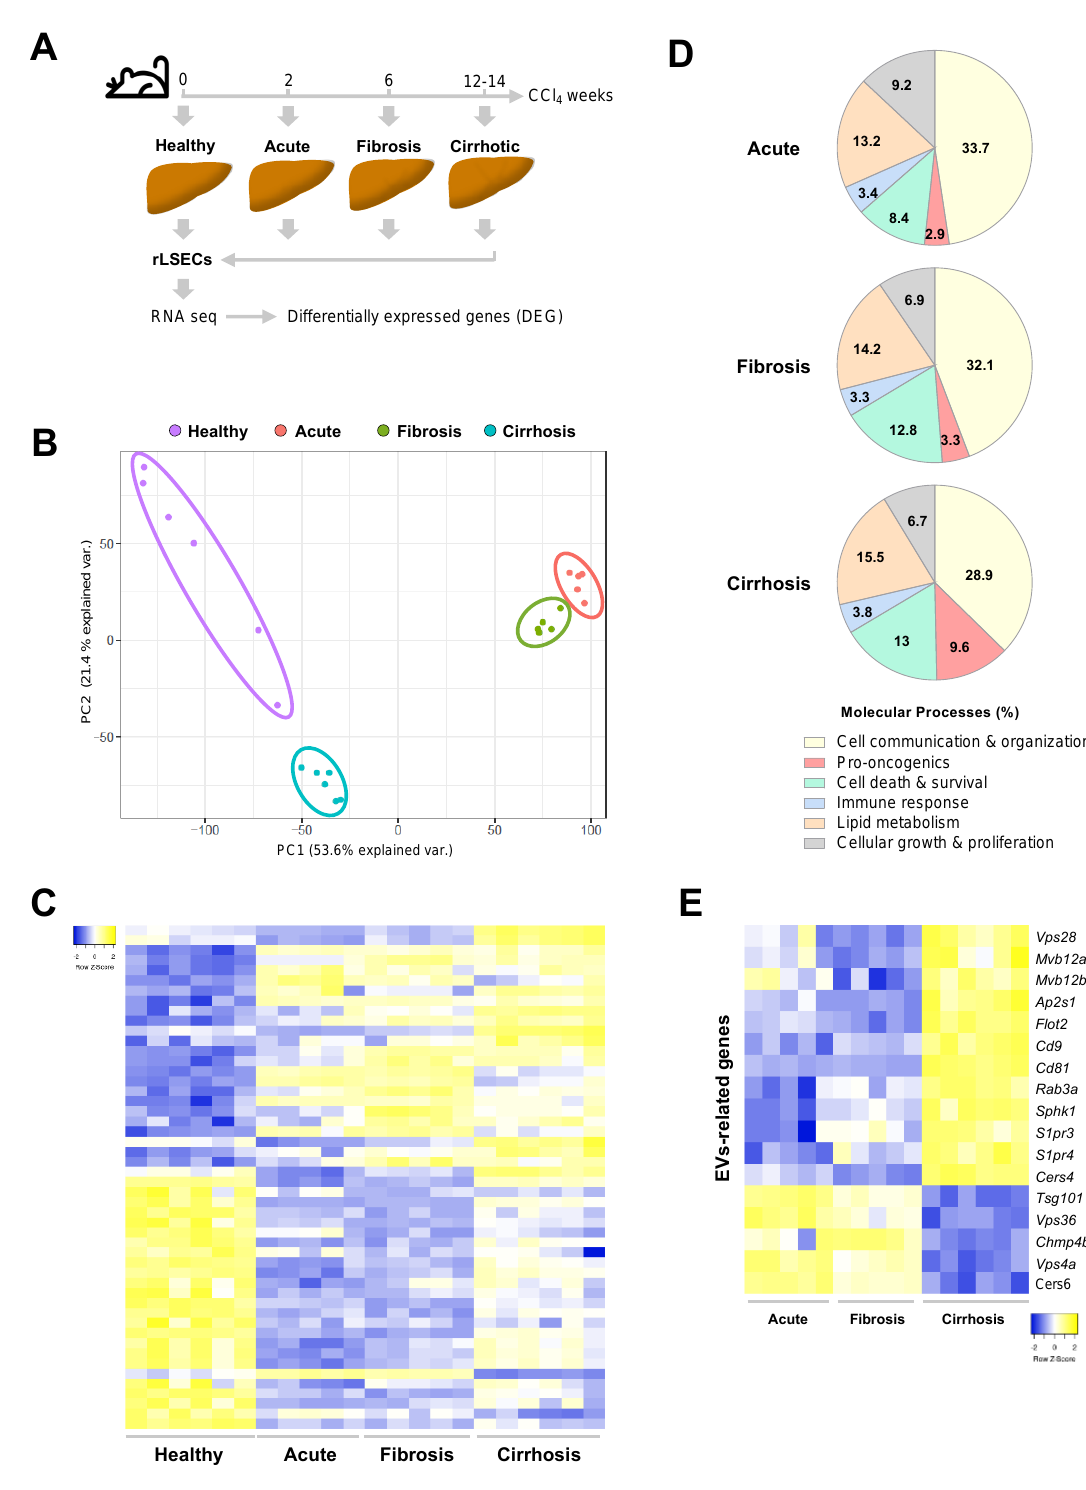
Figure 3. LSECs transcriptome during the progression of CLD. ( A ) Schematic diagram of LSECs isolation and RNAseq during CLD progression. ( B ) Principal Component Analysis representation of LSECs isolated at different stages of liver disease. ( C ) Top 25 up- (yellow) and down-regulated (blue) LSECs genes during CLD progression. Deregulated genes have been ordered according to the fold-change in cirrhotic LSECs. ( D ) Molecular processes of LSECs deregulated genes in each stage of CLD analysed by Ingenuity Pathway Analysis. ( E ) Representative deregulated genes during CLD progression implicated in the biogenesis and exocytosis of extracellular microvesicles. n = 5–6 independent LSECs isolations per disease stage. Differences in RNAseq are considered significant when fold-change > 1.5 and p -value < 0.05.